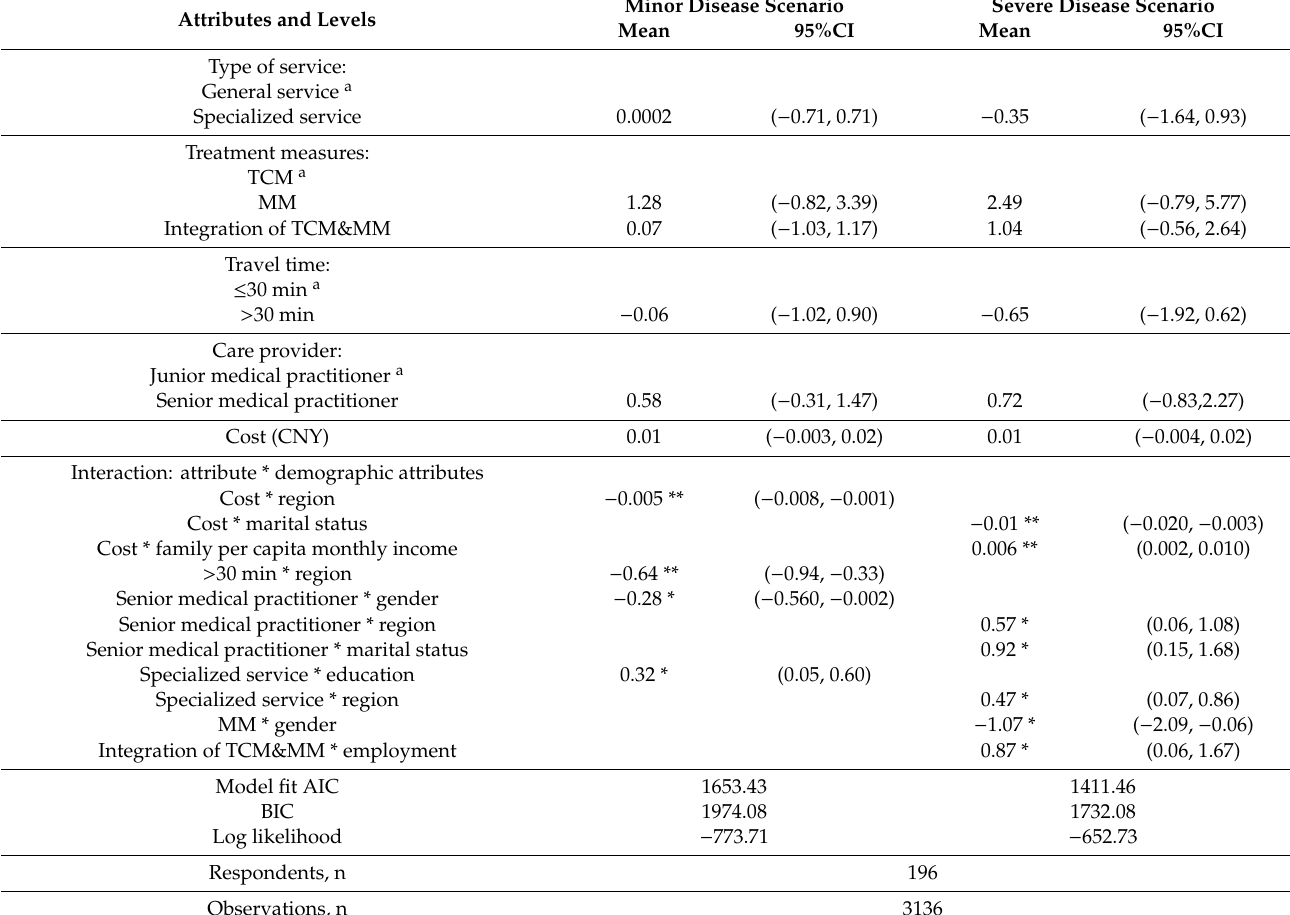
Table 4. Results of the preference heterogeneity